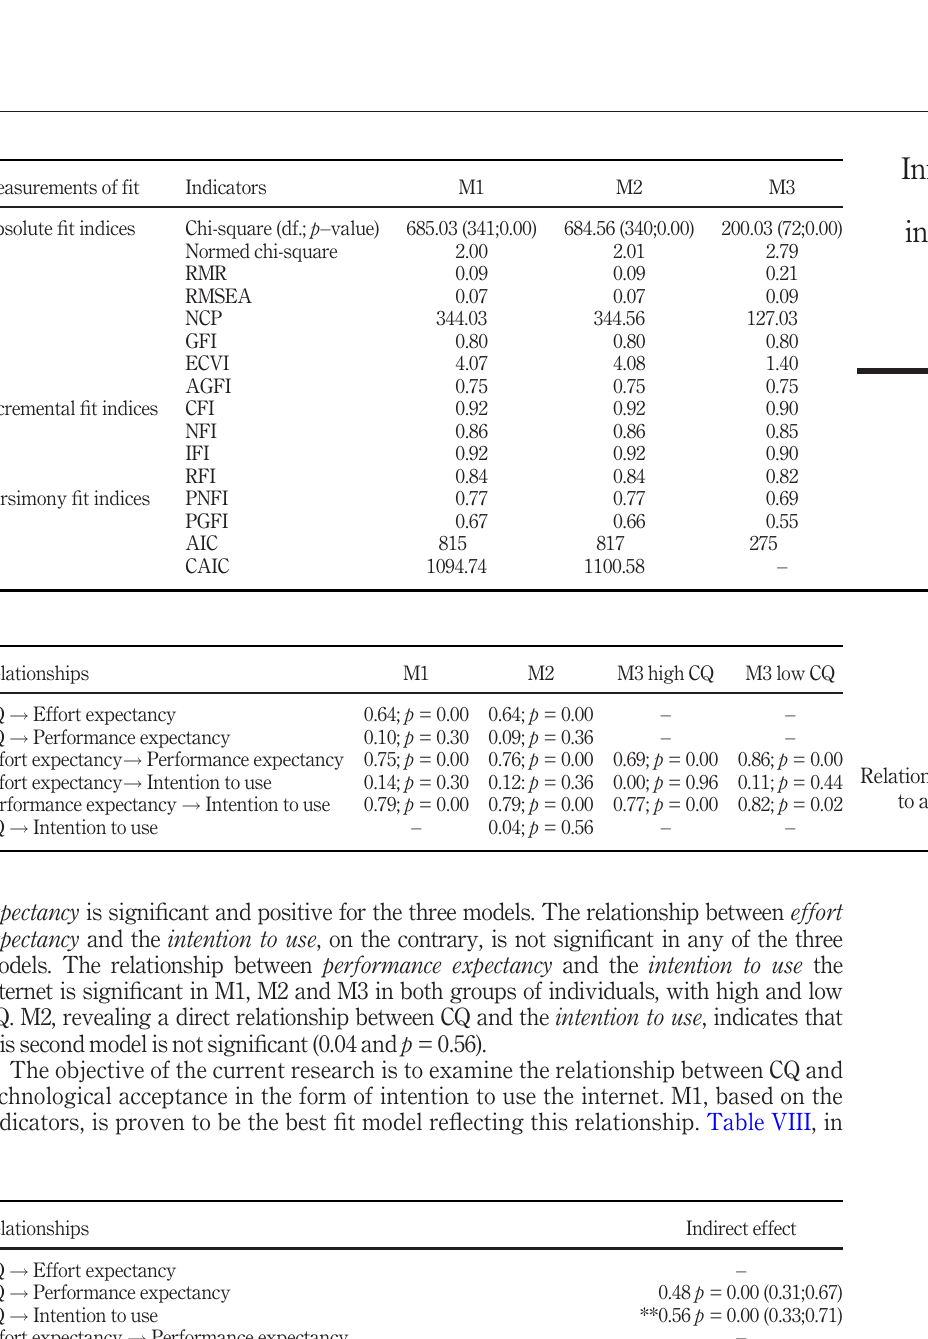
Table VIII. Indirect effects of M1